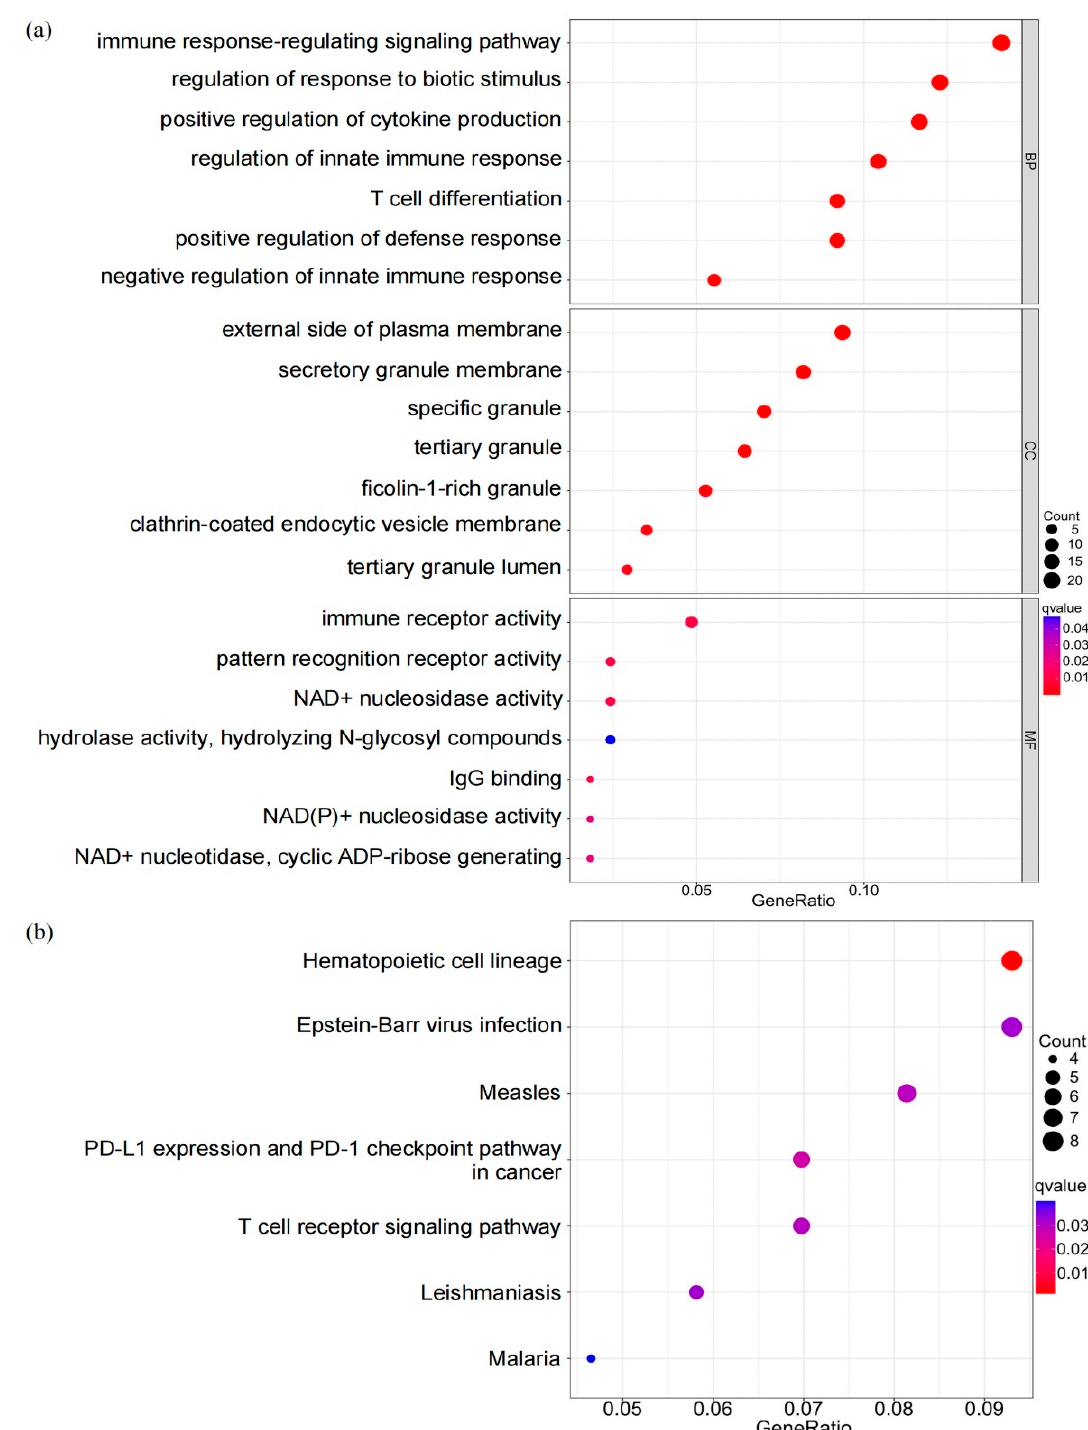
Figure 9. Biological function analysis based on the DEGs. ( a ) Bubble plot of GO enrichment analysis. ( b ) Bubble plot of KEGG enrichment analysis. The x -axis represents the ratio of pathway-enriched DEGs to the total DEGs. The size and color of bubbles correspond to number of genes and q-value of the enrichment significance, respectively. Table 1. The top six most significant GO terms enriched by the 239 DEGs.